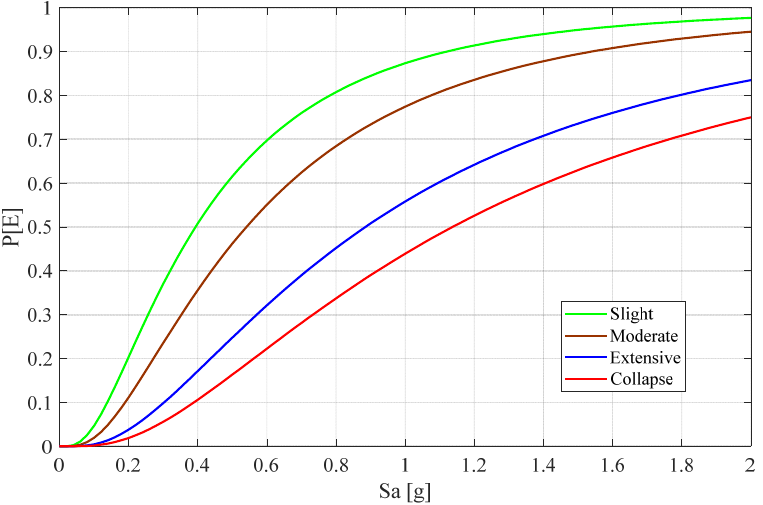
Figure 10. Fragility functions for low-rise RC building for infill frame model without considering soil–structure interaction.